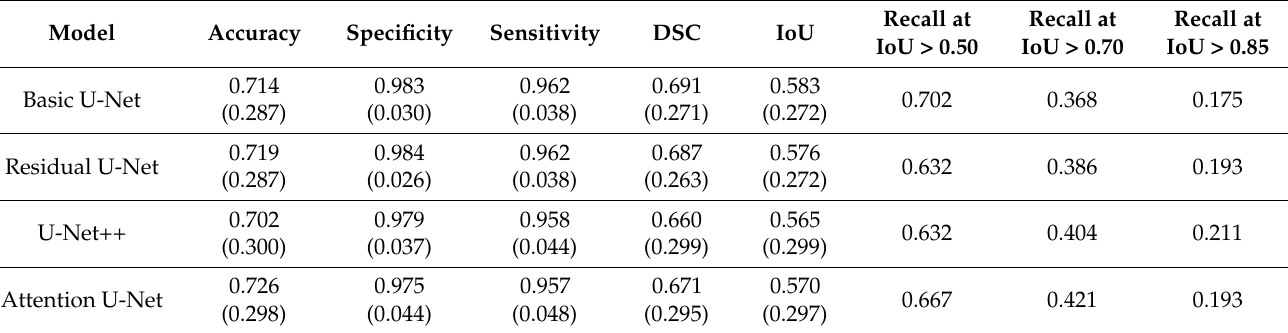
intersection over union. A recall score greater than the threshold is